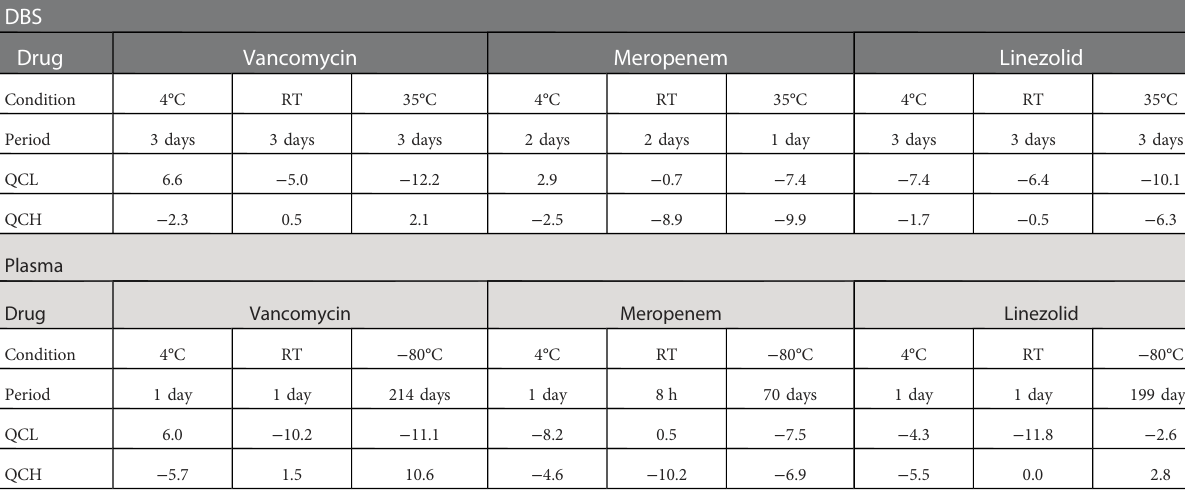
TABLE 4 Results of stability for vancomycin, meropenem, and linezolid in plasma and DBS ( n =3). DBS Drug Vancomycin Meropenem Linezolid